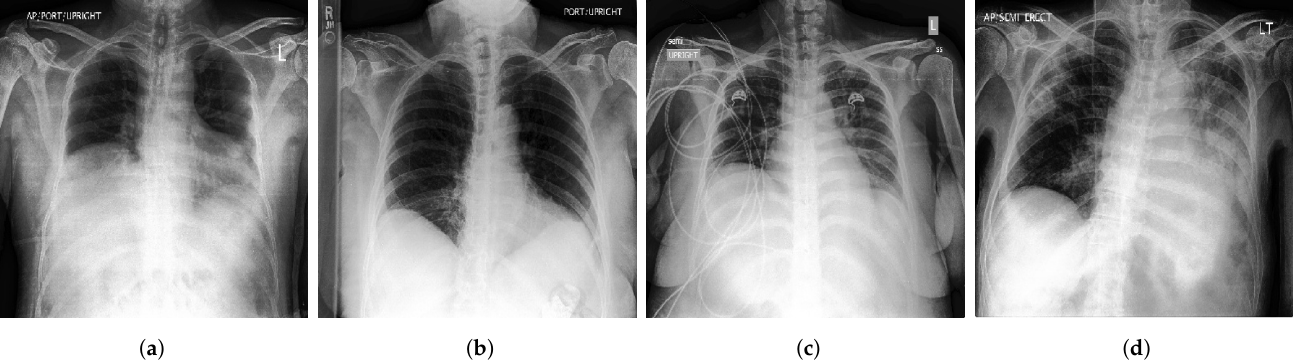
Figure 3. Samples of CXR images from CheXpert dataset [44] where, ( a ) Atelectasis; ( b ) Cardiomegaly; ( c ) Edema; ( d ) Pneumonia.